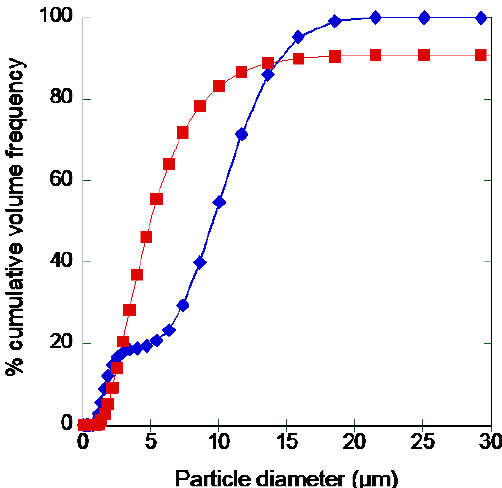
Figure 3. Particle size distribution analysis of SD-rAAT right after preparation (blue diamonds) and after 2 weeks of storage at − 80 ◦ C (red squares).